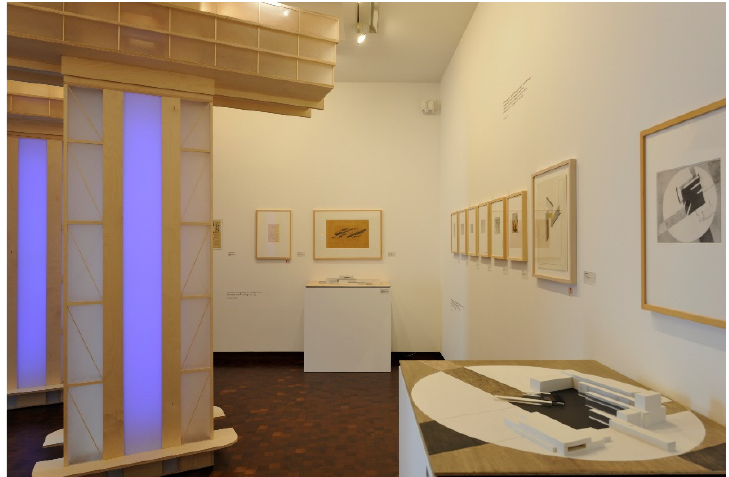
Figure 25. View of one of the rooms in the exhibition ‘Lissitzky+: Victory over the Sun’, Van Abbemuseum, 2009. Left: Model after El Lisstzky, ‘Wolkenbügel’, construction by Van Abbemuseum, 2009. Right: Model after El Lissitzky, ‘The City’, construction by Henry Milner, 2009. Van Abbemuseum. Photo: Peter Cox.